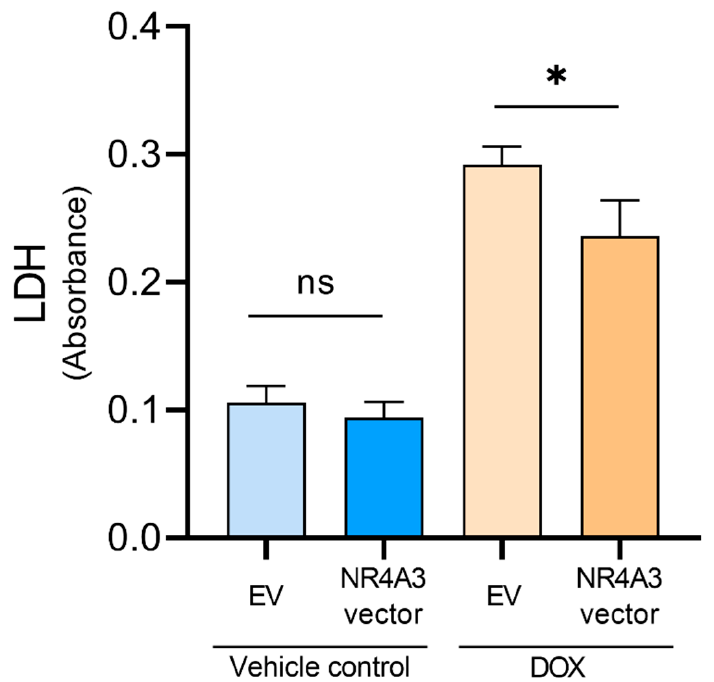
Figure 1. Effect of NOR-1 overexpression on cell death measured by LDH release in DOX-treated CMs. CMs were transfected with expression vectors encoding NR4A3 or the respective empty vector (EV) before treatment with 5 µ M of DOX for 12 h. The extent of cell death was determined by measuring LDH release in the condition medium after DOX treatment. Absorbance was measured at 490 nm. Biological replicates in each group ( N = 4), with three technical replicates for each biological replicate. The graph is presented with mean ± SD. ns = p > 0.05 (not significant), * = p ≤